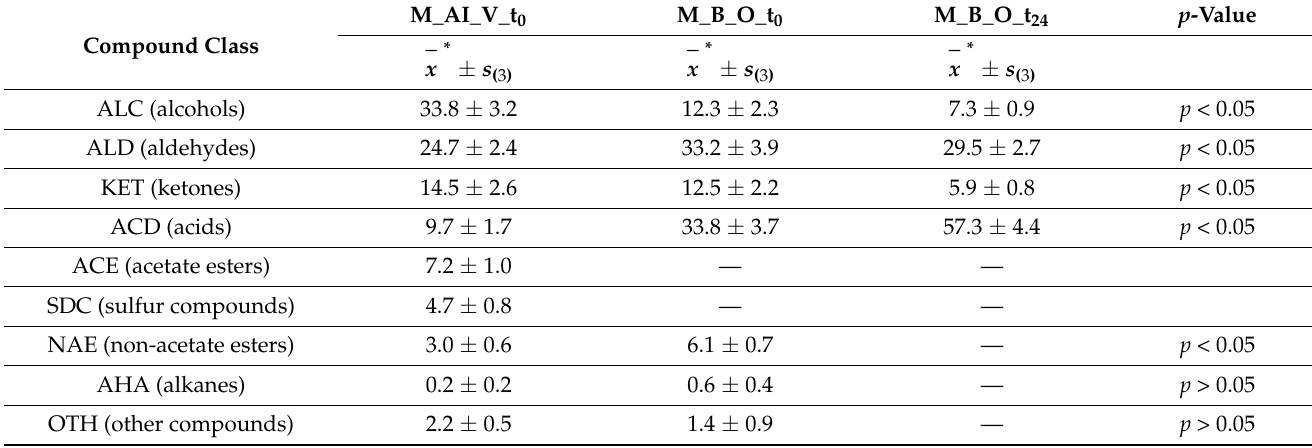
Table 4. Compound classes identified in the HS-SPME-GC-MS analysis * of the fiber samples obtained from winter melon